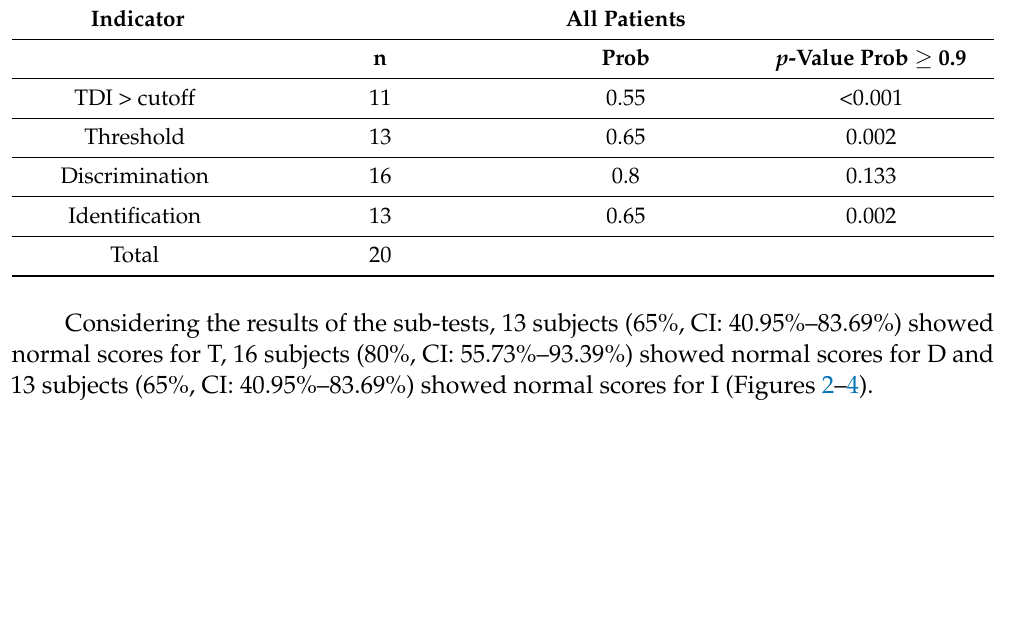
Figure 1. Histogram showing the difference between TDI scores and the normosmic minimum TDI score. TDI (threshold + discrimination + identification). Table 1. Statistical analysis.